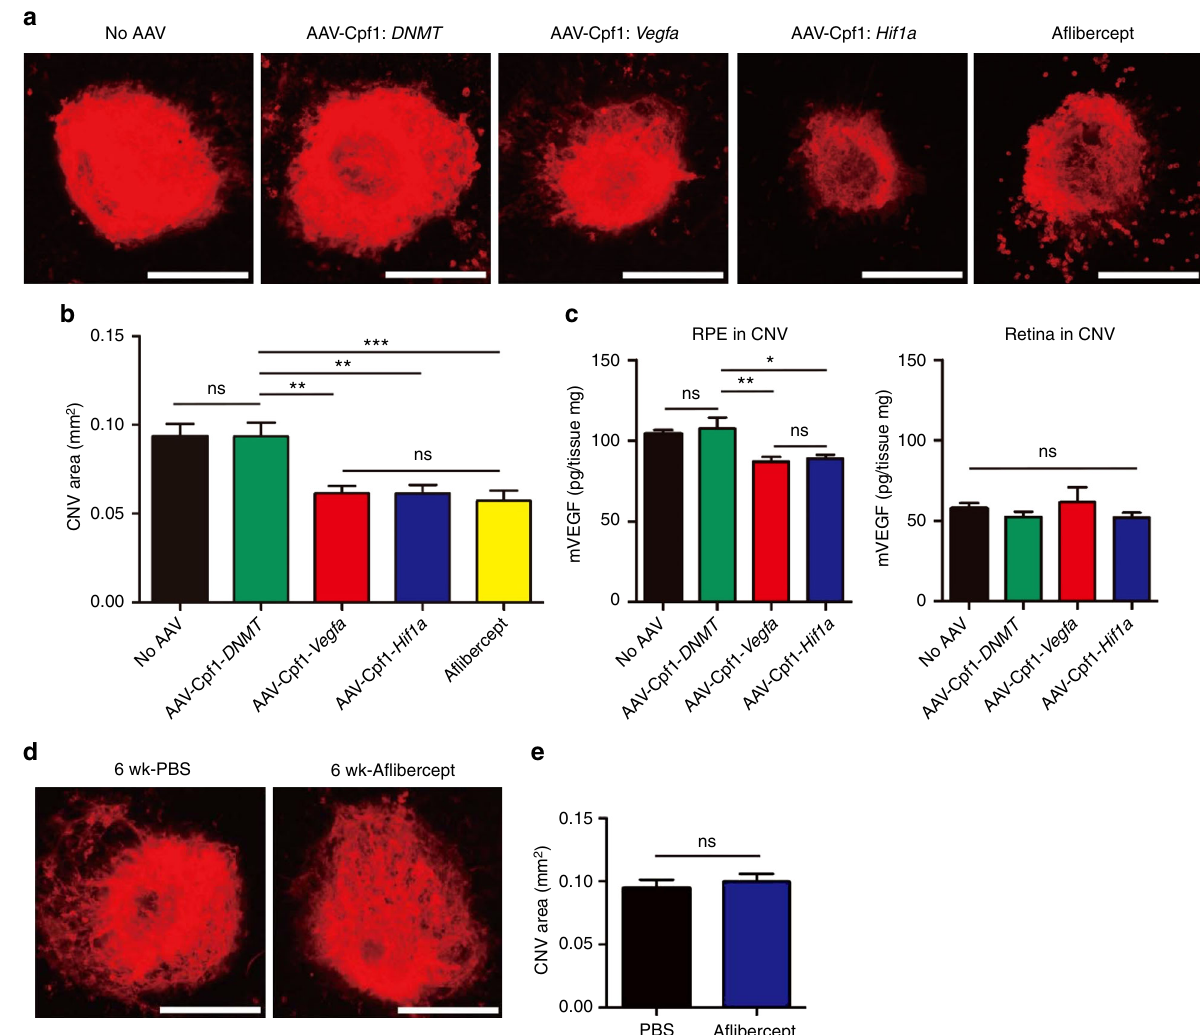
Fig. 3 LbCpf1 targeted to Vegfa or Hif1a reduces the area of laser-induced CNV in mice. a – c At day 42 post-injection of AAV-Cpf1, mice were treated with laser to induce CNV. A fl ibercept (2.5 μ g) was intravitreally injected immediately after laser treatment. No AAV indicates no injection of AAV or a fl ibercept as a control. Three days after laser treatment, Vegfa protein levels were measured by ELISA in the retina and RPE complex. One week after laser treatment, the CNV area was analyzed. a Representative laser-induced CNV stained with isolectin B4 in mouse eyes injected with AAV-Cpf1 targeted to DNMT , Vegfa , or Hif1a . Scale bar is 200 μ m. b The CNV area. Error bars indicate s.e.m. ( n = 20). One-way ANOVA and Tukey ’ s post-hoc tests, * P < 0.05, ** P < 0.01, *** P < 0.001, ns, not signi fi cant. c VEGFA protein levels. Error bars indicate s.e.m. ( n = 10). One-way ANOVA and Tukey ’ s post-hoc tests. *, P < 0.05; **, P < 0.01; ns not signi fi cant. d – e Six weeks after intravitreal injection of PBS or a fl ibercept (2.5 μ g), mice were treated with laser to induce CNV. One week after laser treatment, the CNV area was analyzed. d Representative laser-induced CNV stained with isolectin B4 in mouse eyes injected with PBS or a fl ibercept. Scale bar is 200 μ m. e The CNV area. Error bars indicate s.e.m. ( n = 30). Student ’ s t- test. ns, not signi fi